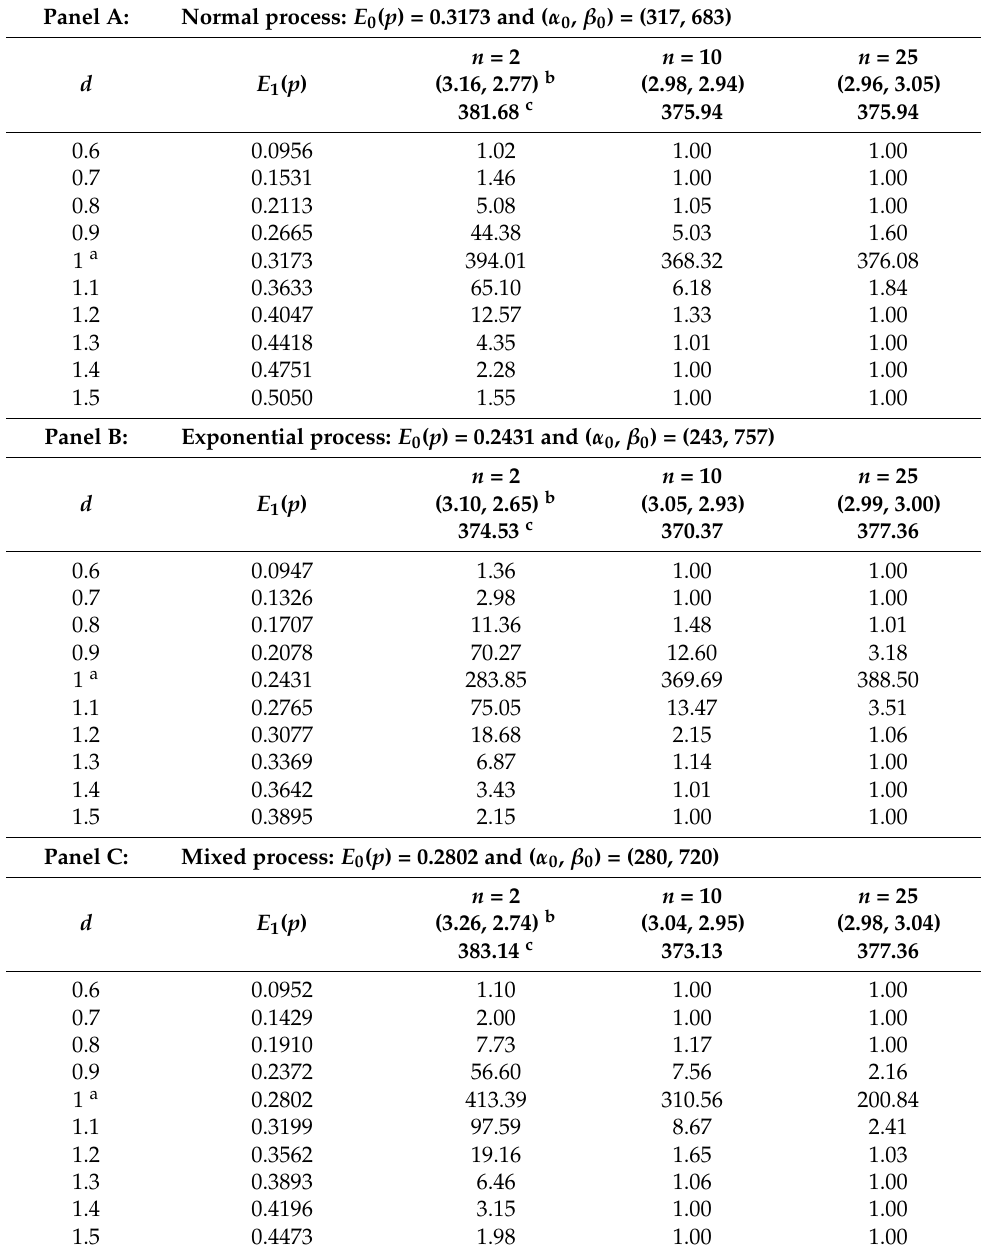
Table 7. The simulation results of the ARL 1 s of the proposed Bayesian EWMA variance chart under three different processes ( λ =